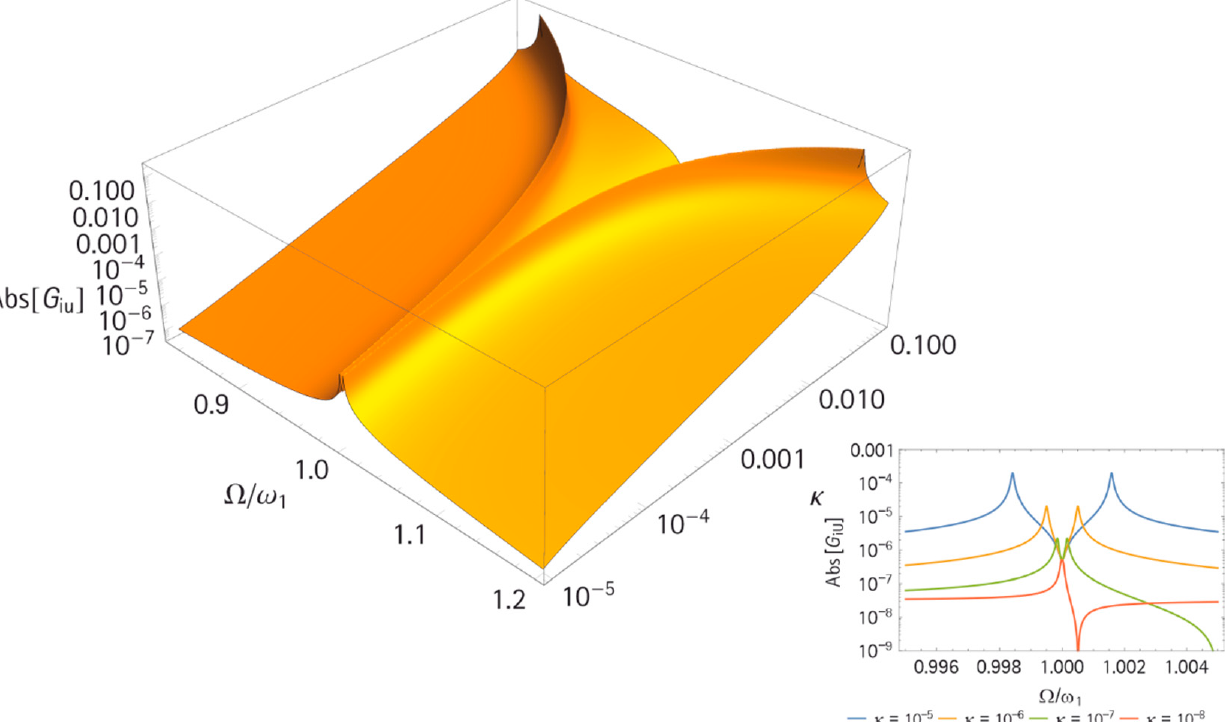
Figure 6. Magnitude of the admittance ( G iU ) for varying κ values, (left) 3D representation for a large range of κ , (right) 2D plot for very small mass ratios, and κ = 10 − 8 . . . 10 − 5 . The used parameters were m = 1 kg; m n = 0; k = 10 N/m; M = m / κ ; k M = k / κ ; D = d M = 5 × 10 − 4 Ns/m; C p = 10 nF; and α = 0.1